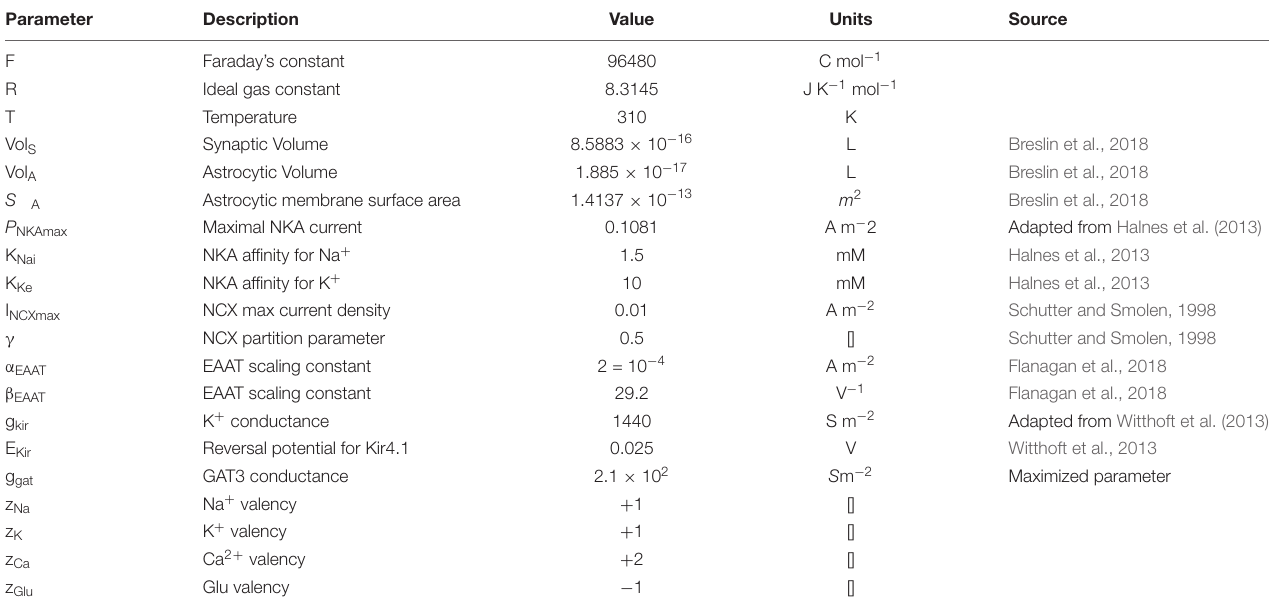
TABLE 5 | Astrocytic membrane transporter